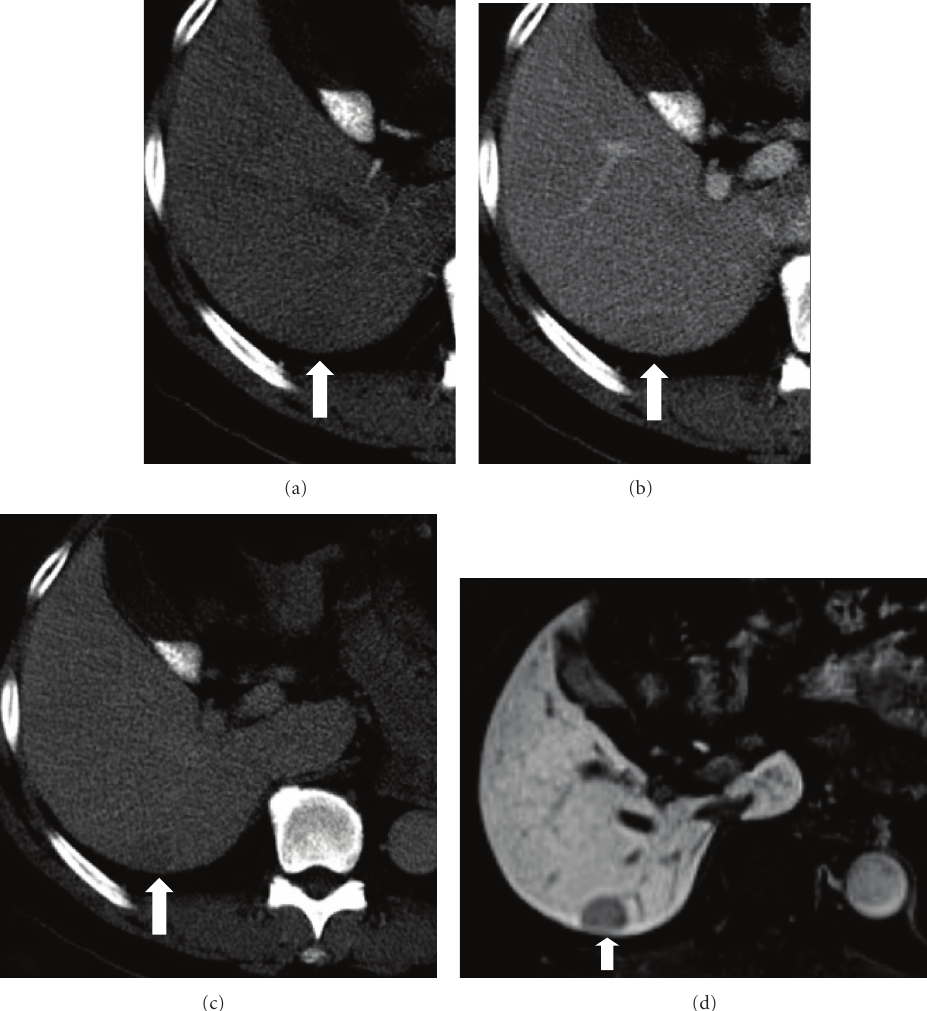
Figure 2: (a–c) Contrast-enhanced CT in the arterial, venous and equilibrium phases of a 75-year-old male Hepatitis B virus carrier showing an indeterminate slightly hypodense nonhypervascular nodule in the liver segment 6. (d) Gadoxetate acid-enhanced MRI in the hepatobiliary phase 20 minutes after injection showing a hypointense nodule against the background of enhancing liver parenchyma, implying lack of lesional uptake, suspicious for HCC or high-grade dysplastic nodule. Final surgical histopathology was a well-di ff erentiated Edmondson- Steiner grade I